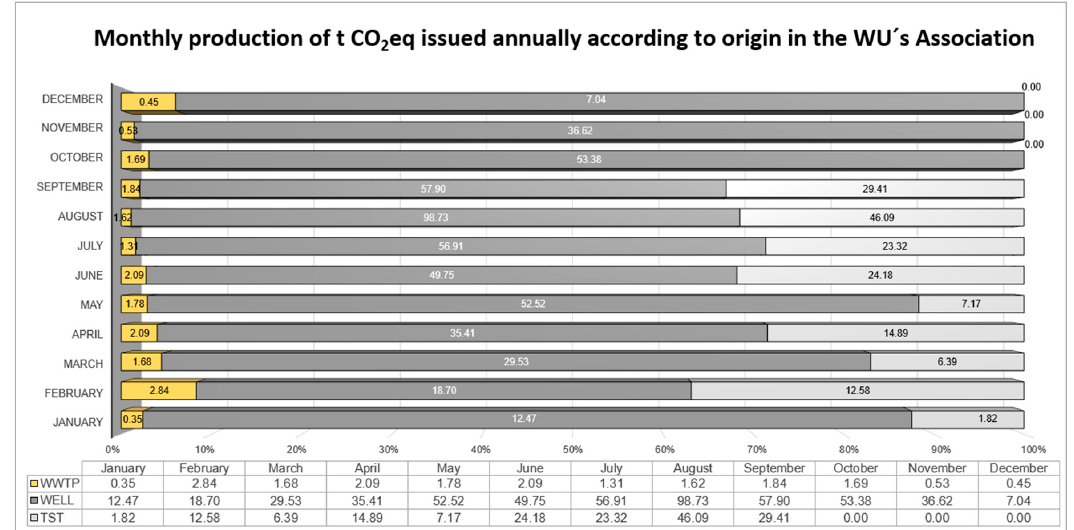
Figure 4. % t CO 2 eq flow rate to the atmosphere. 2016. Source: Own elaboration.